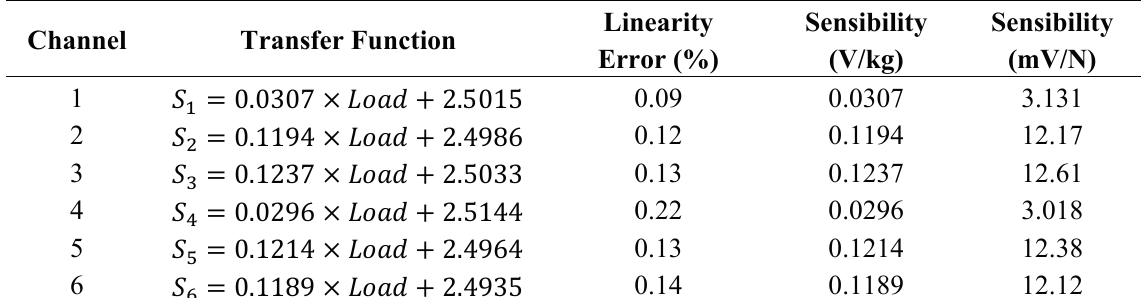
Table 2. Conditioning channels characteristics.